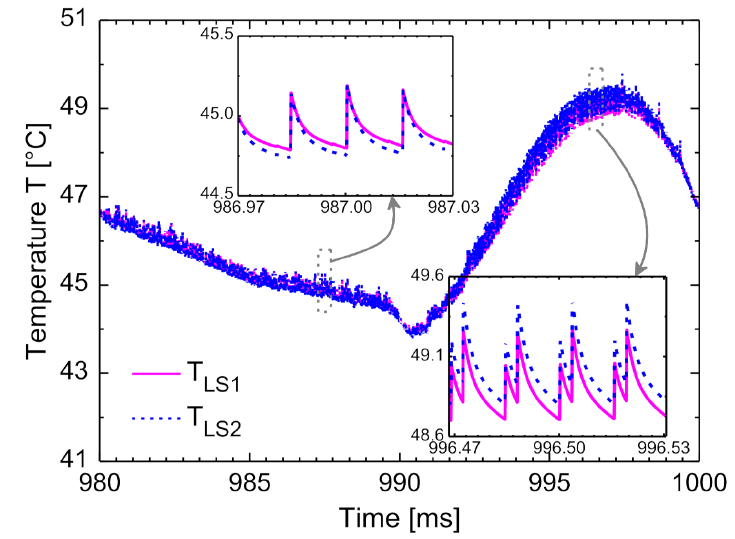
Figure 14. Simulated temperature of the LS devices vs. time in the last 20 ms window. Magnifications highlighting the temperature ripple in four-period-long windows are also reported on the top-left and bottom-right corners.